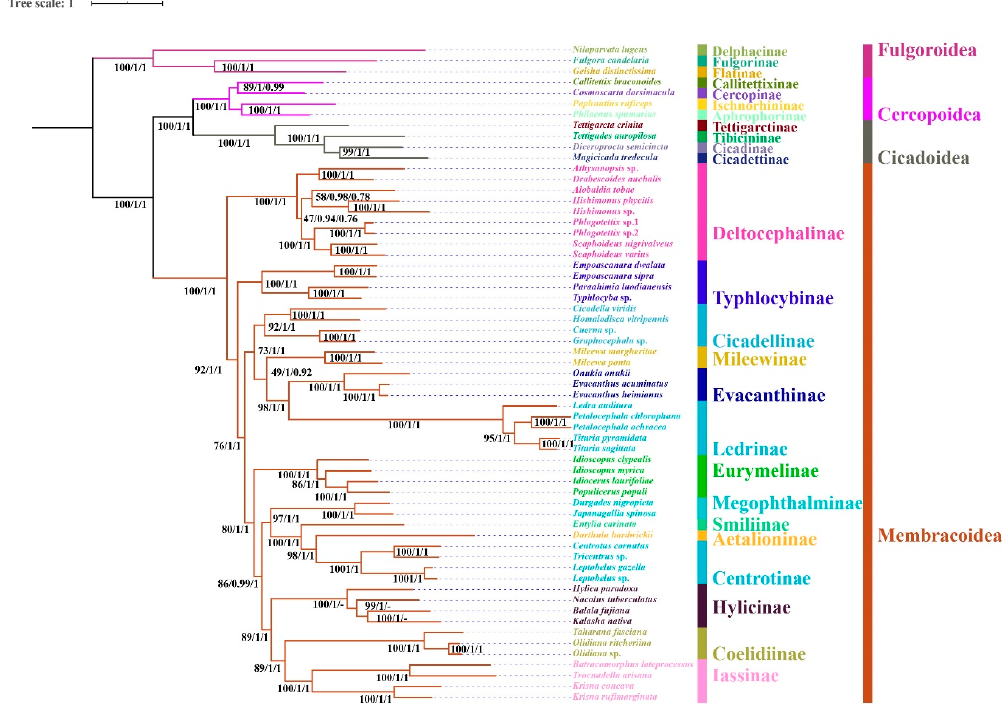
Figure 6. Phylogenetic tree produced by IQtree / MrBayes based on the dataset of P123R and MrBayes based on the dataset of P123. Numerals at nodes are bootstrap support values (BS) and Bayesian posterior probabilities (PP). “-” indicates the clades or species are different in Bayesian inference (BI).